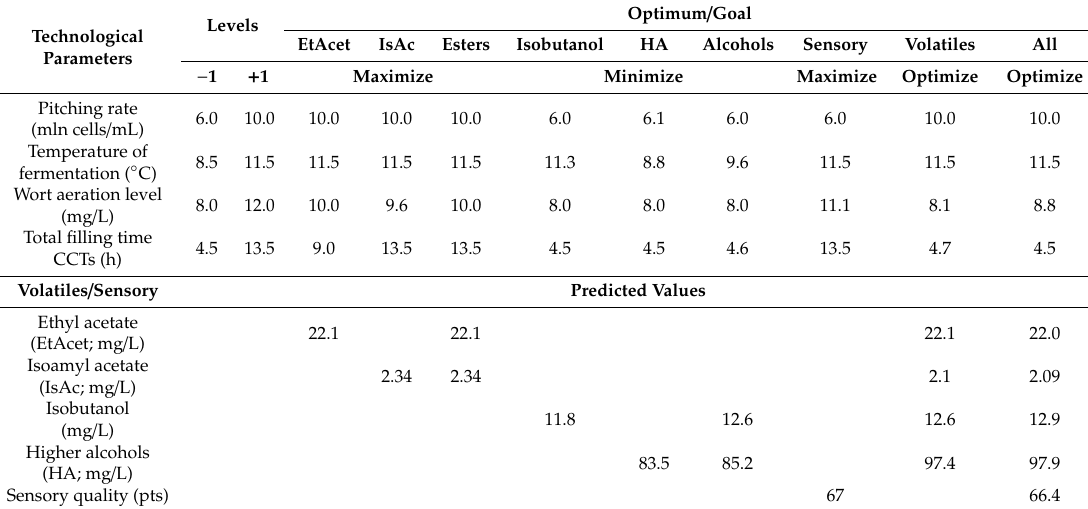
Table 8. Values of process parameters that optimized ethyl acetate, isoamyl acetate, isobutanol concentration, and the sensory quality of beer with corresponding predicted values, and the multiple response optimization: Esters = ethyl acetate + isoamyl acetate; alcohols = butanol + higher alcohols, volatiles = esters + alcohols, and all = esters + alcohols + sensory